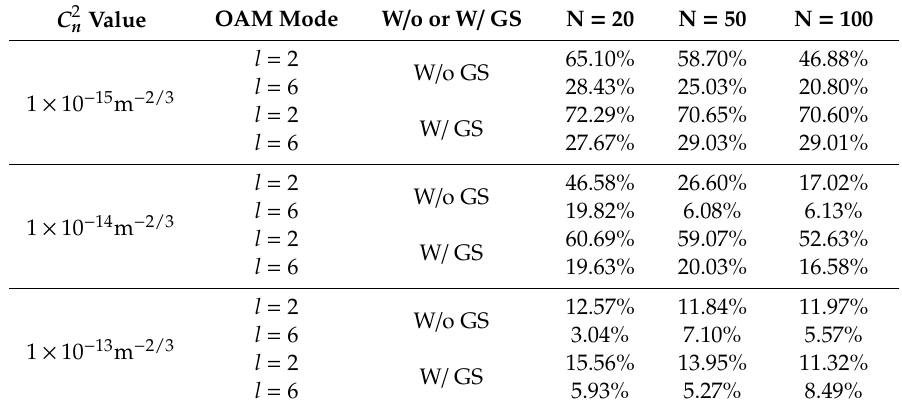
Table 4. The PD values of OAM beams without (W / o) and with (W) GS algorithm corresponding to Figure